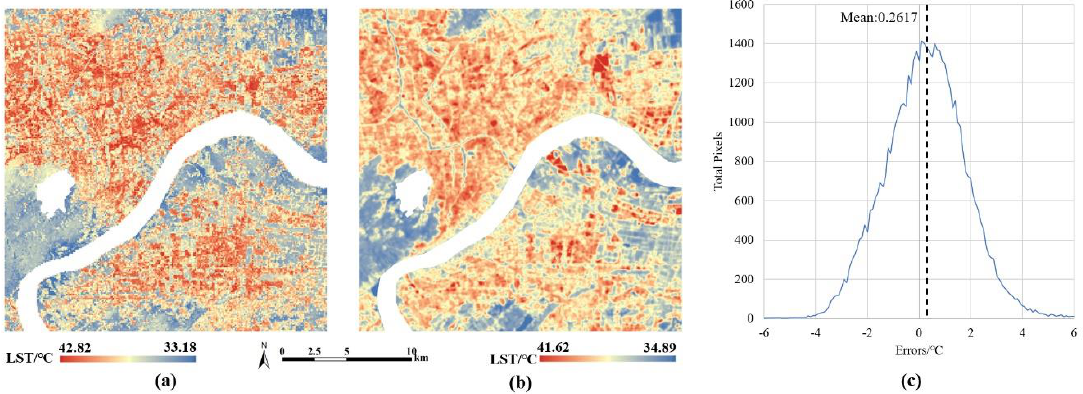
Figure 16. Validation results during summer daytime: ( a ) downscaled LST with a resolution of 100 m; ( b ) retrieved LST with a resolution of 30 m; ( c ) error distribution histogram between downscaling LST and real LST. (the black dashed line represents the mean value).